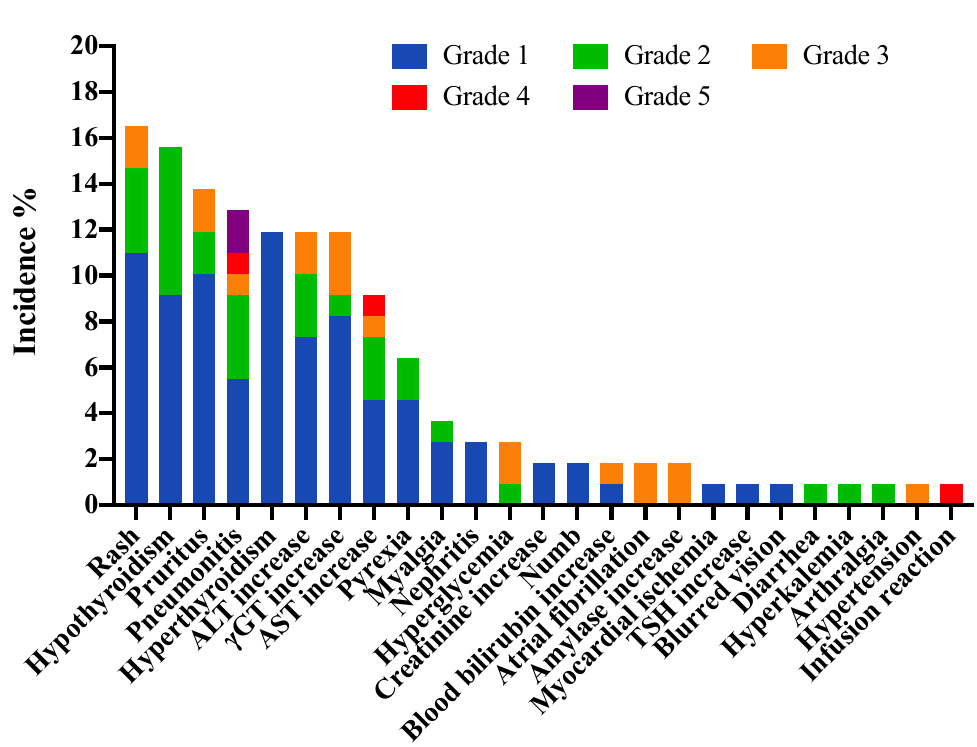
Figure 1. Profiles of immune-related adverse events among 109 advanced non-small cell lung cancer patients. Abbreviation: ALT, alanine transaminase; AST, aspartate aminotransferase; γ GT, gamma- glutamyltransferase. Table 2. Immune-related adverse events (irAEs) by characteristics and resolution rates.